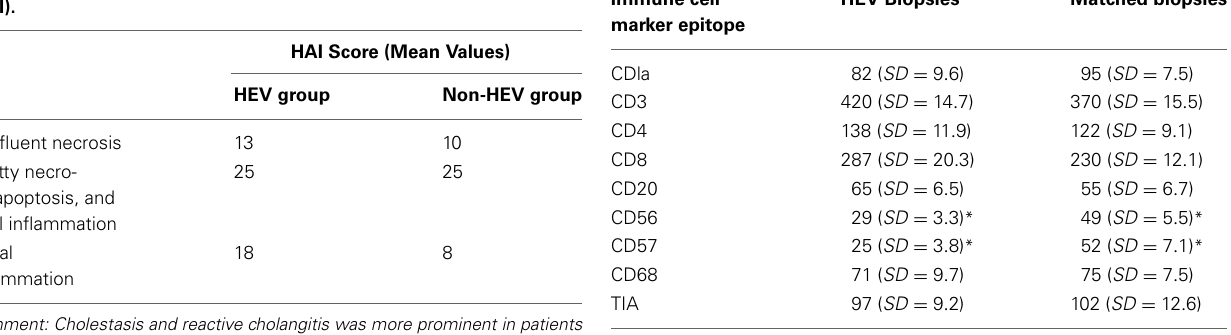
Table 3 | Histopathology in 7 HEV patients and matched cohort of 7 non-HEV patients scoring according to the hepatitis activity index (HAI).